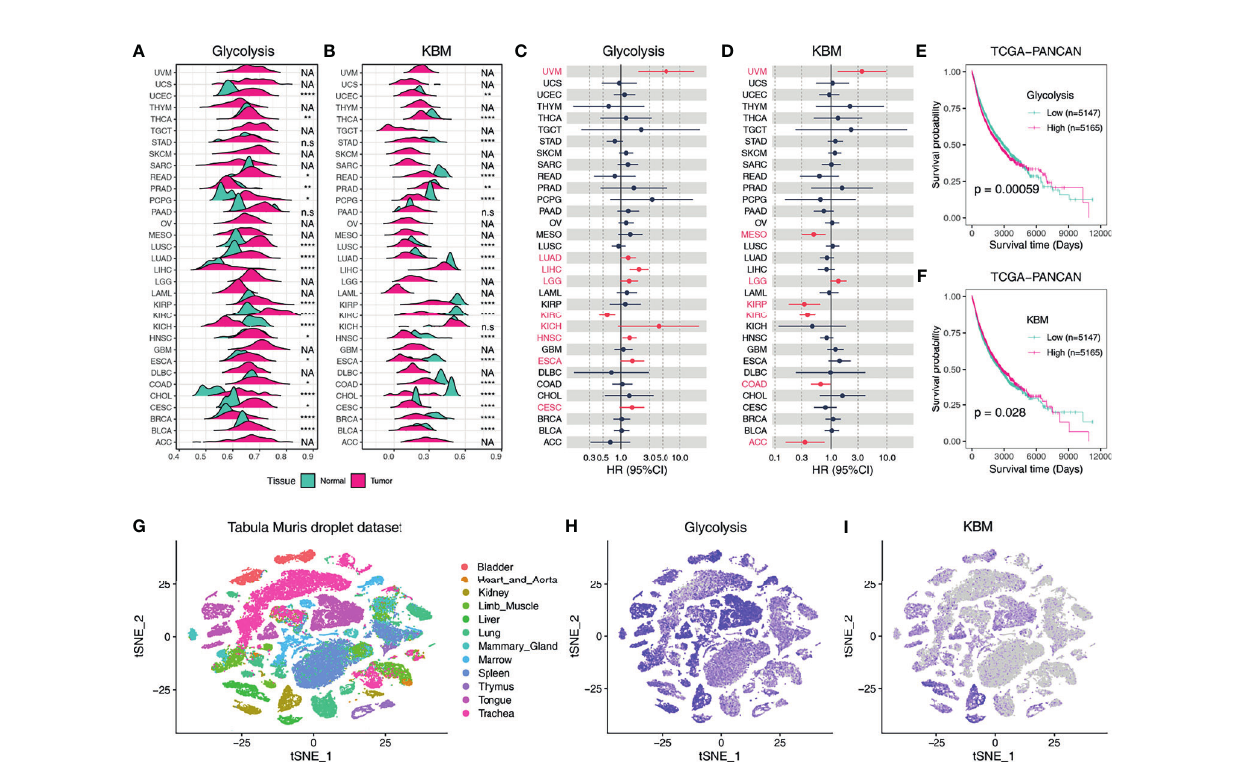
FIGURE 2 | The expression pro fi les and clinical relevance of glycolysis and KBM activity based on ssGSEA score. Ridgeline plot shows the metabolic activity of glycolysis (A) and KBM (B) pathway in non-tumor tissues and tumor tissues across TCGA cancer types based on ssGSEA score. The p-value was determined by Student ’ s t-test. Forest plots show the hazard ratio (HR) of overall survival of the glycolysis (C) and KBM (D) ssGSEA score across cancer types. The cancer types marked in red indicated Cox proportional p-value <0.1. Kaplan-Meier plots for glycolysis (E) and KBM (F) ssGSEA score in TCGA Pan-Cancer (PANCAN) dataset. ssGSEA is strati fi ed by the median value in each cancer type individually, then combined to generate the survival curve. The p value was determined by log-rank test. (G) t-SNE plot of all cells in Tabula Muris droplet dataset, colored by organ. t-SNE plots showing expression and distribution of glycolysis (H) and KBM (I) ssGSEA score across organs. *p<0.05; **p<0.01; ****p<0.0001. n.s., not signi fi cant; NA, not